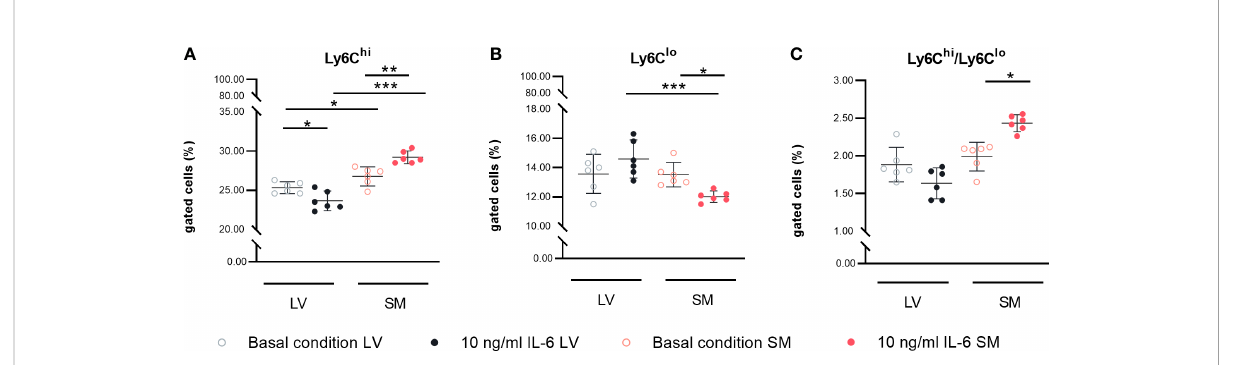
FIGURE 4 IL-6 stimulation leads to attraction of different monocyte subsets to left ventricle (LV)- versus skeletal muscle (SM)-derived fi broblasts. Percentage of gated (A) CD11b + CD115 + Ly6C hi and (B) CD11b + CD115 + Ly6C lo monocytes and (C) ratio of Ly6C hi versus Ly6C lo monocytes attracted by the medium of LV-derived (black) and SM-derived (red) fi broblasts after 72-h culture with basal medium without IL-6 (basal condition; bright hollow circle) or with 10 ng/ml of IL-6 (dark fi lled circle), n = 18, N = 3; Kruskal – Wallis/one-way ANOVA. All data are presented